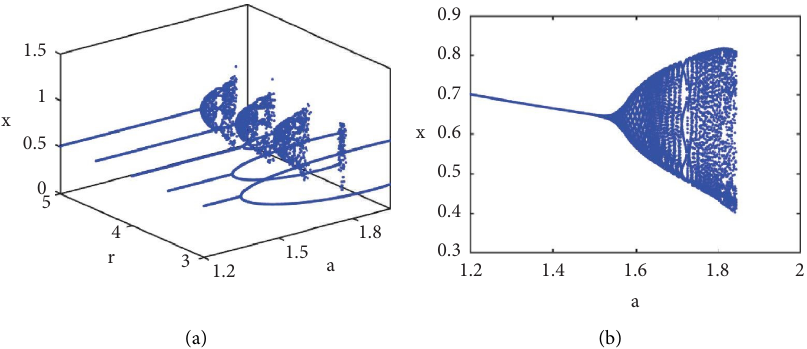
Figure 5: (a) Bifurcation diagram of model (4) in ( a,r,x ) plane. (b) Bifurcation diagram of model (4) in ( a, x ) plane with r � 4 .